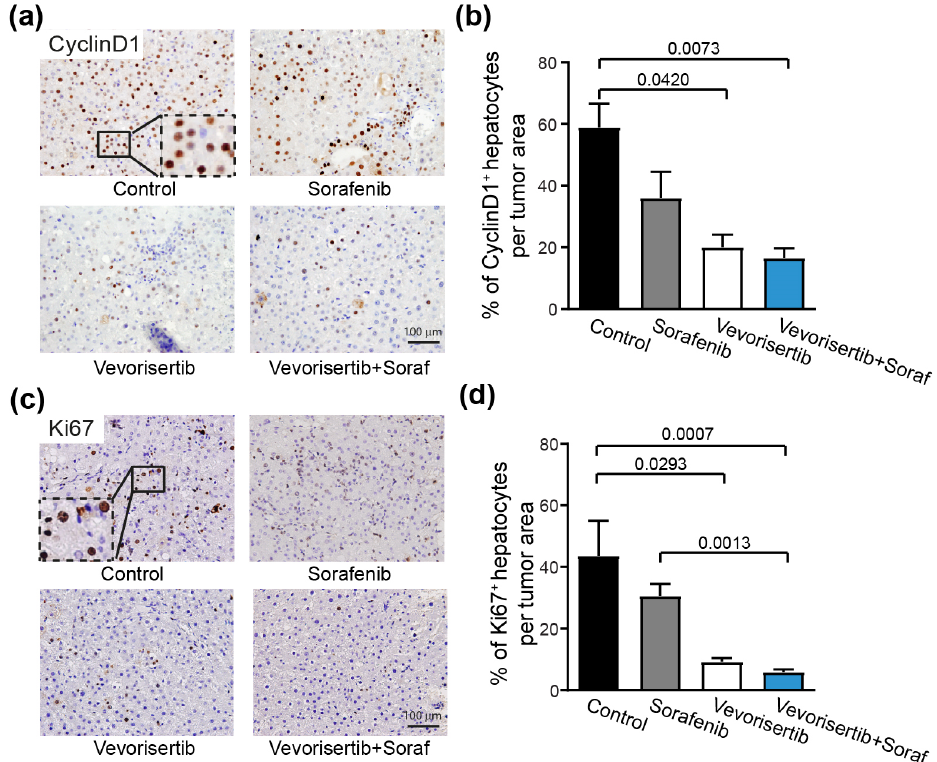
Figure 3. Effect of vevorisertib and vevorisertib + sorafenib treatment on tumor cell proliferation. ( a ) Representative images of nuclear Cyclin D1 staining of control, sorafenib, vevorisertib and vevorisertib + sorafenib treated group, 20 × magnification and ( b ) quantification of % of Cyclin D1 positive hepatocytes per tumor area. ( c ) Representative images of nuclear Ki67 staining of control, sorafenib, vevorisertib and vevorisertib + sorafenib treated group, 20 × magnification and ( d ) quantification of % of Ki67 positive hepatocytes per tumor area. n = 7/group, values are mean ± SE. Kruskal–Wallis test was used for multiple